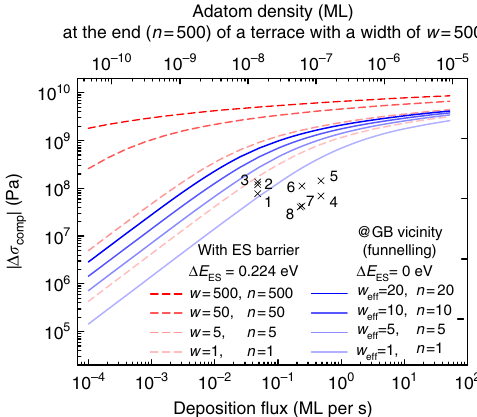
Figure 3 | Reversible stress jumps for a (111) textured copper film as a function of flux. The dashed red curves are calculated for typical terraces (1 o w o 500 and D E ES ¼ 0.224eV), whereas the solid blue curves describe terraces in the vicinity of GBs ( w eff r 20 and D E ES ¼ 0eV ), where funnelling takes place. The top horizontal axis shows the adatom density for a typical surface terrace ( w ¼ 500 and D E ES ¼ 0.224eV). Crosses show experimentally reported literature values: 1, 2, 3 (ref. 8), 4 (ref. 43), 5, 6 (ref. 9), 7 (ref. 36) and 8 (ref. 44). Note that the stresses are lower, if it is easier for atoms to diffuse to and into